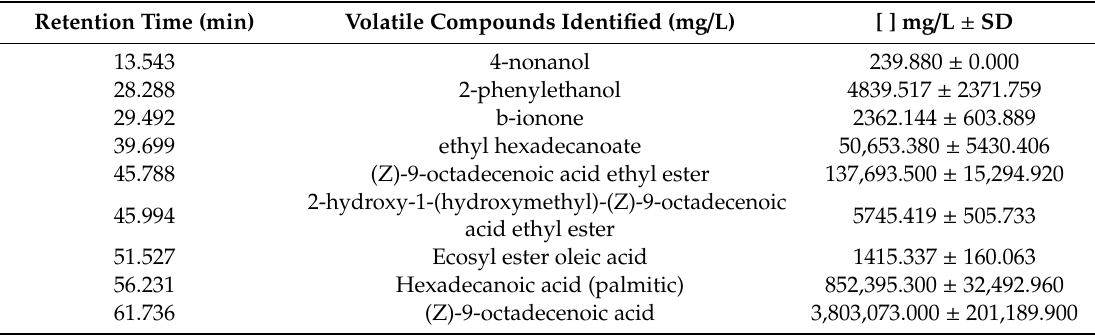
Table 1. Minority volatile compounds in buriti oil.